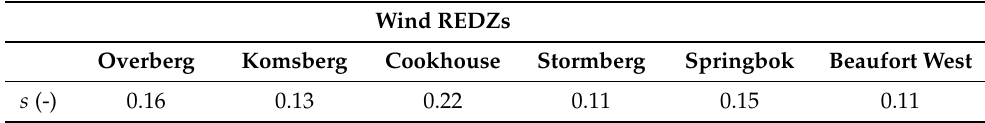
Table 5. Surface roughness coefficient for the wind